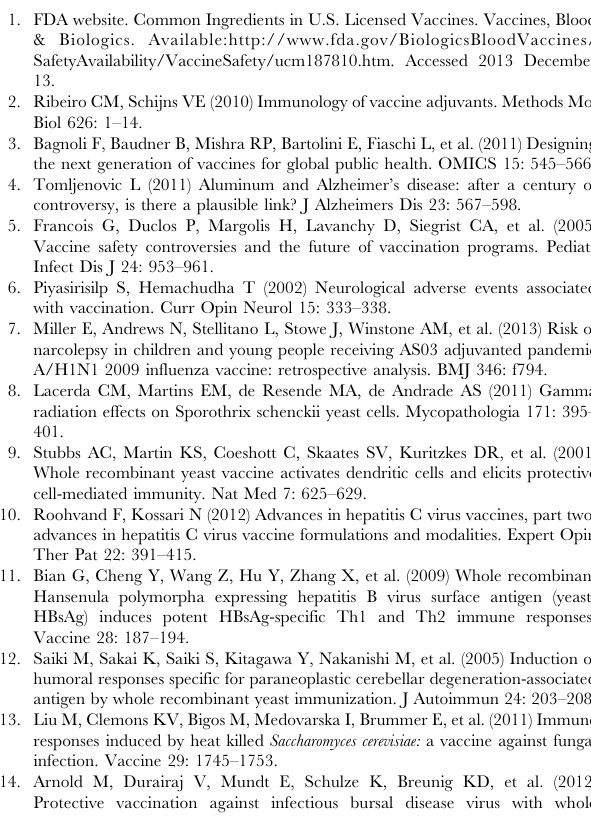
Figure S1 Optimized nucleotide sequence of the N (A) and PbCS (B) proteins for expression in GS115, KM71 and SMD1168 P. pastoris strains. The nucleotide sequence of the linker between N and PbCS is given in the box ( B ); ( C ) Kyte-Doolitle hydropathy profile (DNA Strider1.4f18) of N-PbCS: negative values correspond to hydrophilic amino acid motifs. Figure S2 Total RNA (A, B and C) and Total Soluble Protein (TSP; D, E and F) in fractions (Fr) and pellets from ultracentrifuged samples (U) in duplicate. ( A and D )